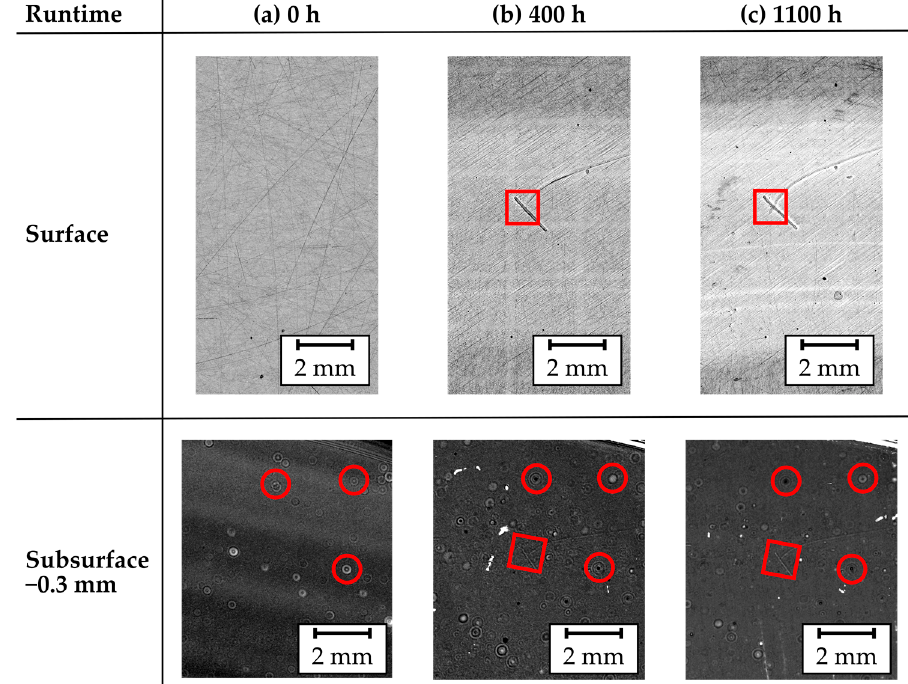
Figure 13. Optical (top) and acoustic (bottom) microscope images after: ( a ) machining; ( b ) 400 h runtime at 250 min − 1 with surface damage; ( c ) test termination with 1100 h runtime at 250 min − 1 .